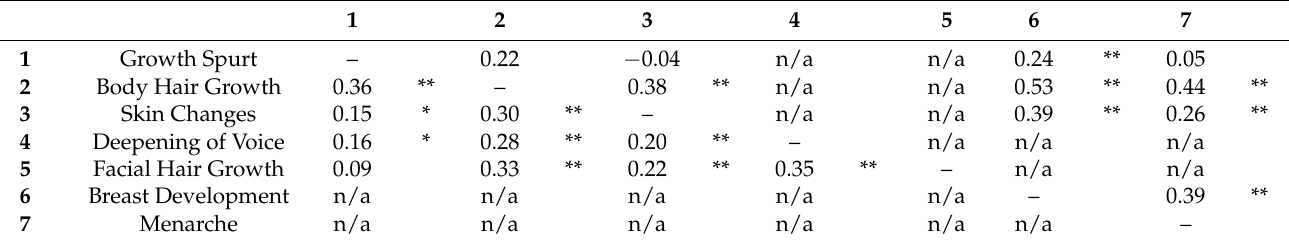
Table 1. Bivariate Correlations Among Pubertal Facets in Boys and Girls.